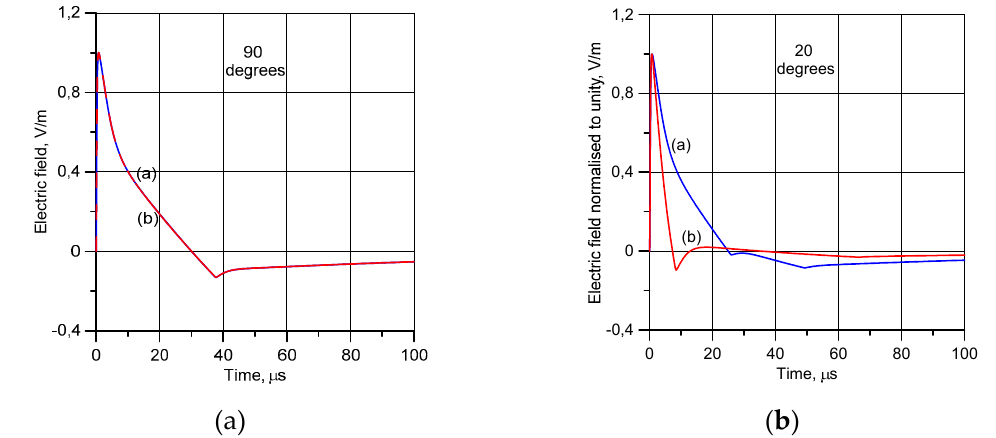
Figure 3. Electric radiation field of subsequent return stroke, based on the MTLL model, at two di ff erent elevation angles ( a ) θ = 90 ◦ and ( b ) θ = 20 ◦ . The results are shown for two di ff erent return stroke speeds with (a) 1.5 × 10 8 m / s and (b) 2.5 × 10 8 m / s. The parameter H in the MTLL model is changed with changing return stroke speed so that the temporal variation of the waveforms for the two speeds are identical at 90 ◦ . Observe that all field amplitudes are normalized to unity. The angle θ is defined in Figure 2.